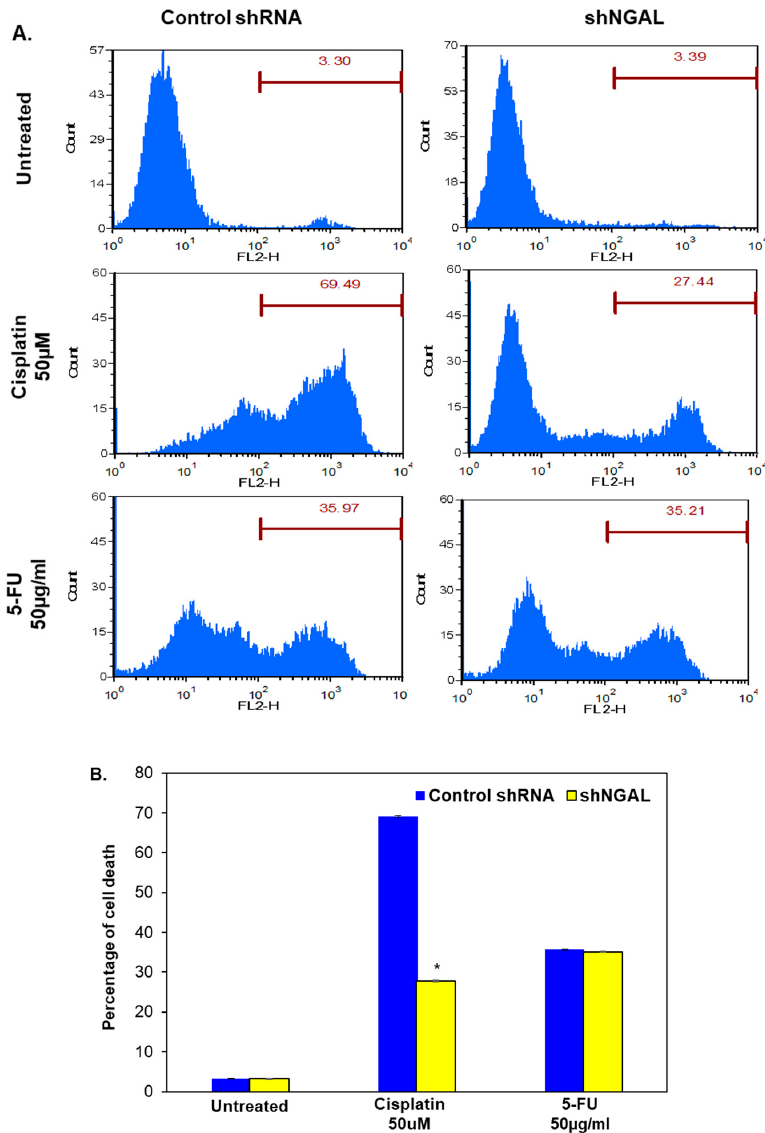
Figure 6. Silencing of NGAL selectively induces resistance against cisplatin. ( A ) Cells were treated with cisplatin and 5-FU, and percentage of cell death was measured by staining with propidium iodide on flowcytometry at 48 h. ( B ) Graphical representation of percentage of cell death ( n = 3). Data are means ± SE. * = p <